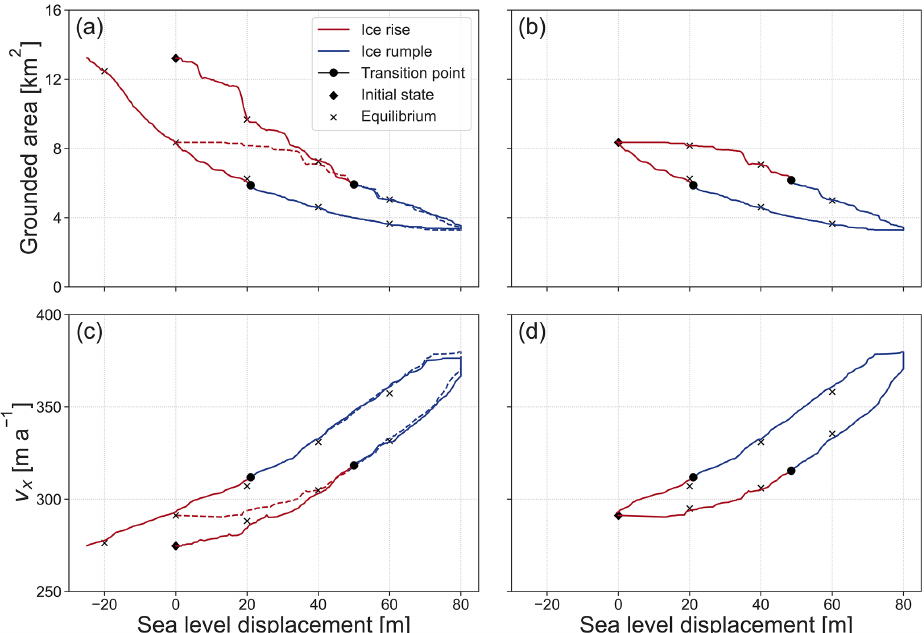
Figure 8. The response of grounded area and upstream ice shelf velocity to sea level perturbation in the case of low basal friction. Panels (a) and (c) show the evolution for the first sea level increase-and-decrease cycle in blue and red. Panels (b) and (d) show the evolution for the second increase-and-decrease cycle. These curves are also plotted in panels (a) and (c) with dashed red and blue lines for comparison. The crosses represent the results of steady-state branches of the transient simulations at corresponding sea levels. The transition from ice rise to rumple and vice versa is represented by the black dots and a change in colour of the